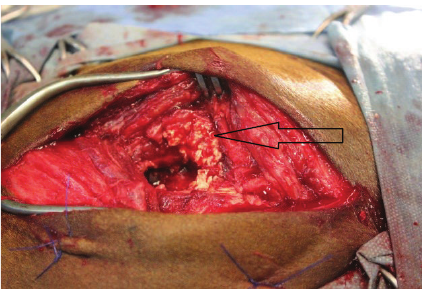
Figure 5: View of the bone cyst opening after debridement: prox- imal to the right and distal to the left. The debrided infraspinatus fibres (black arrow) are visible dorsal to the cyst opening.